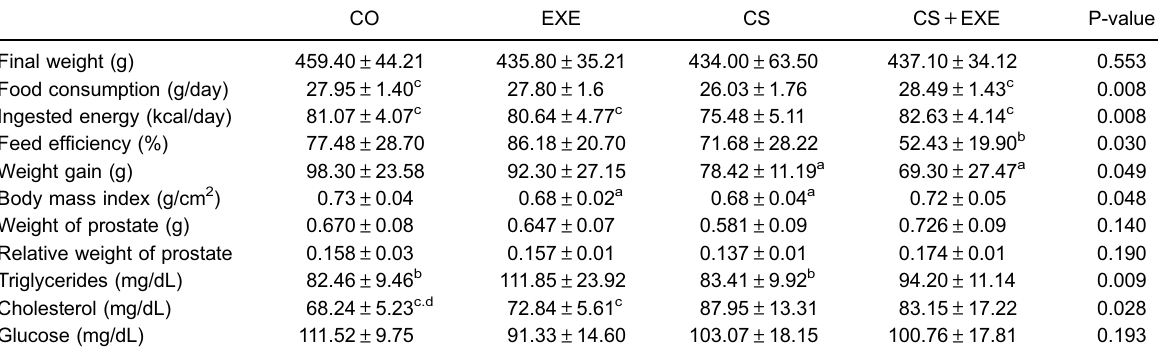
Table 1. Anthropometry and nutritional and biochemical parameters of control animals (CO), animals submitted to exercise (EXE), cigarette smoke exposure (CS), and cigarette smoke exposure with exercise (CS +